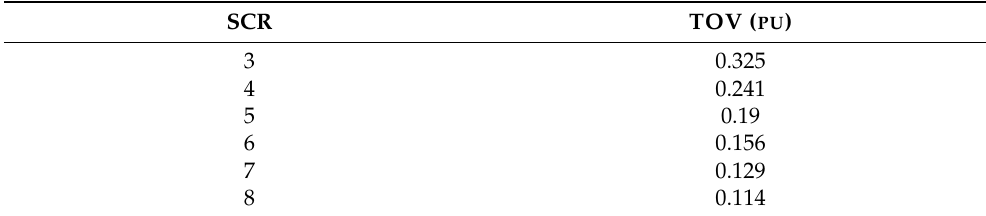
Table 4. Values of TOV when bipolar is blocked. SCR TOV ( PU